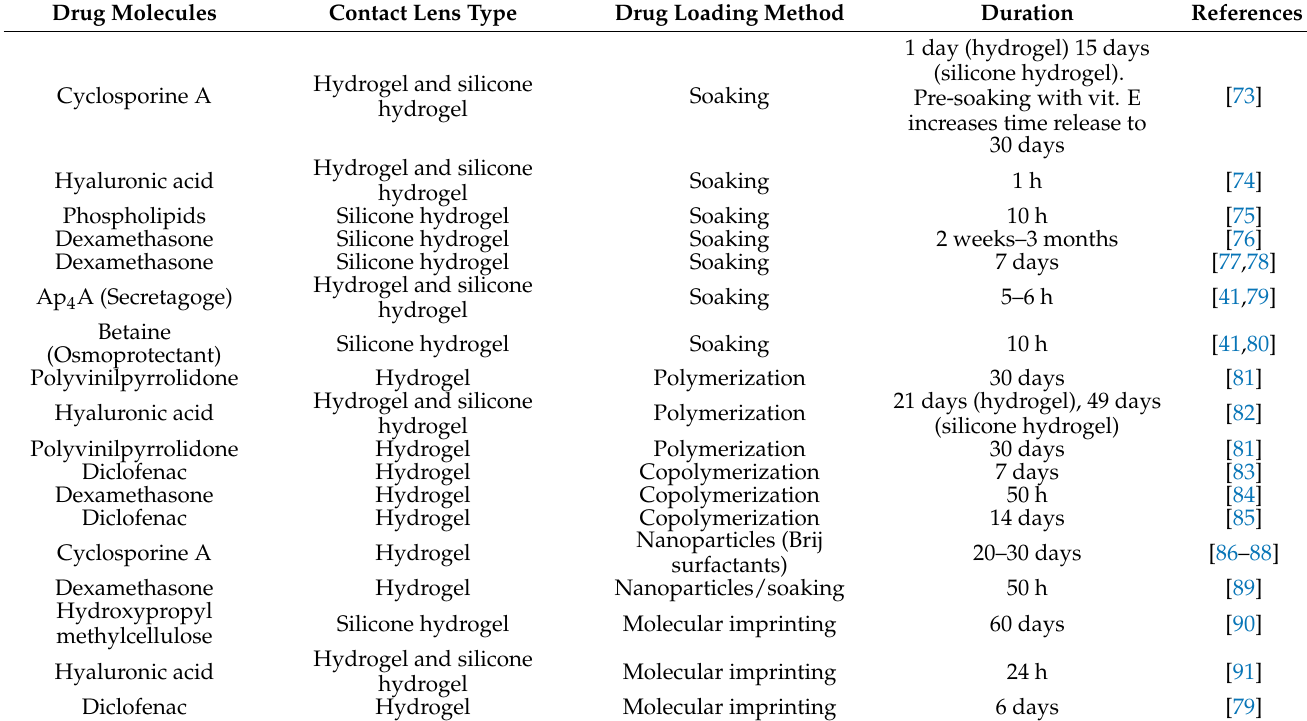
Table 3. DED treatment with contact lens drug delivery